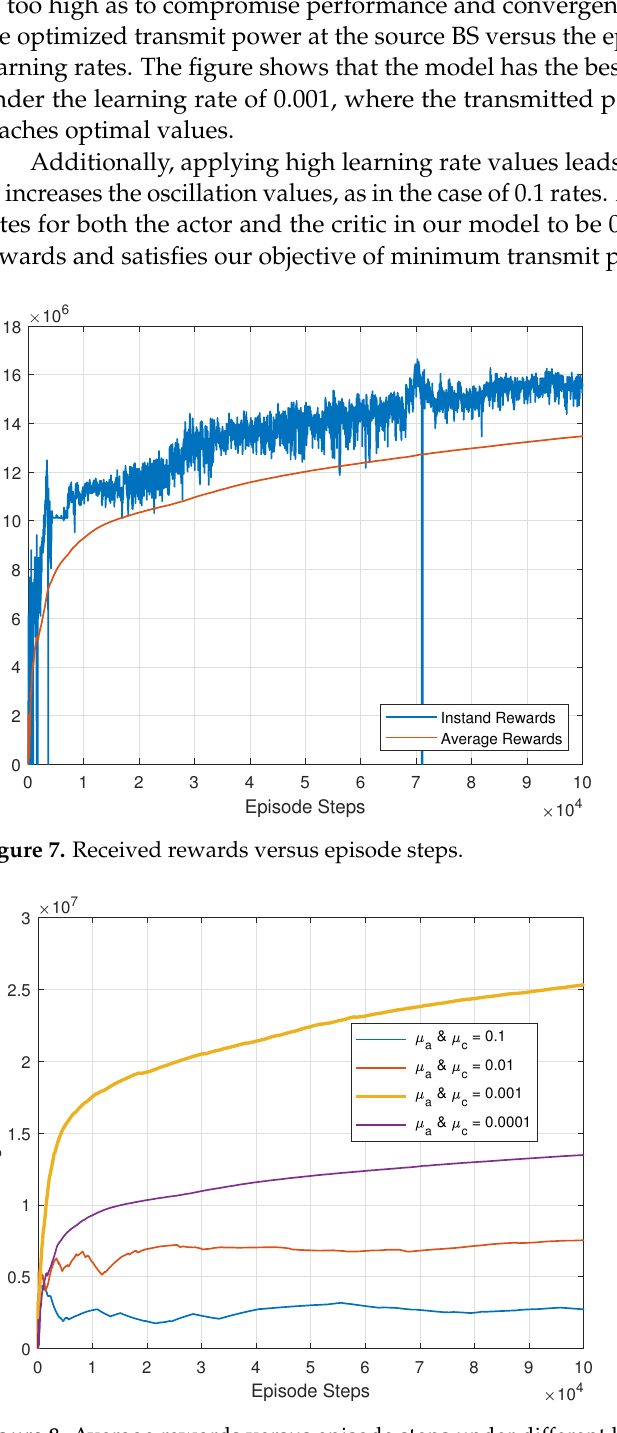
Figure 8. Average rewards versus episode steps under different learning